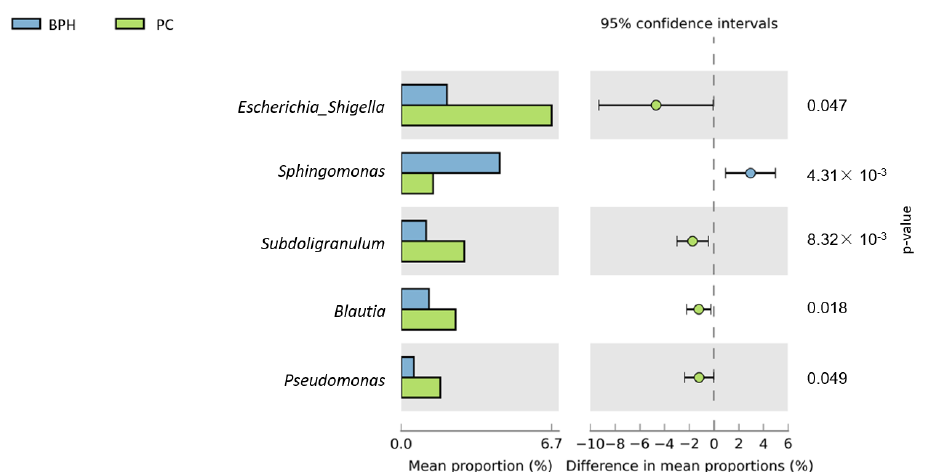
Figure 8. Urine sample microorganism genus relative abundance—BPH vs. PC. Left side of the figure shows mean abundance proportion. Right side shows difference in mean abundance proportions 95% confidence interval.